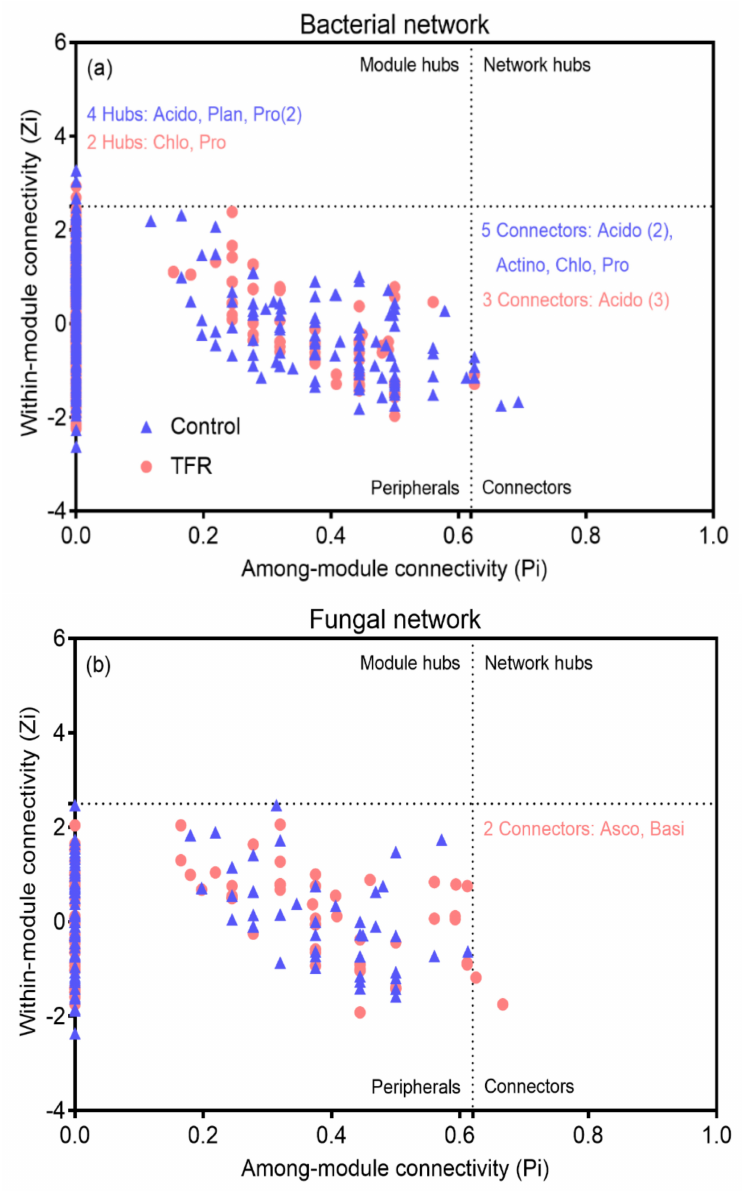
Figure 5. Node classification to ascertain putative keystone species in ( a ) bacterial and ( b ) fungal networks. Acido, Acidobacteria; Actino, Actinobacteria; Chlo, Chloroflexi; Plan, Planctomycetes; Pro, Proteobacteria; Asco, Ascomycota; Basi,